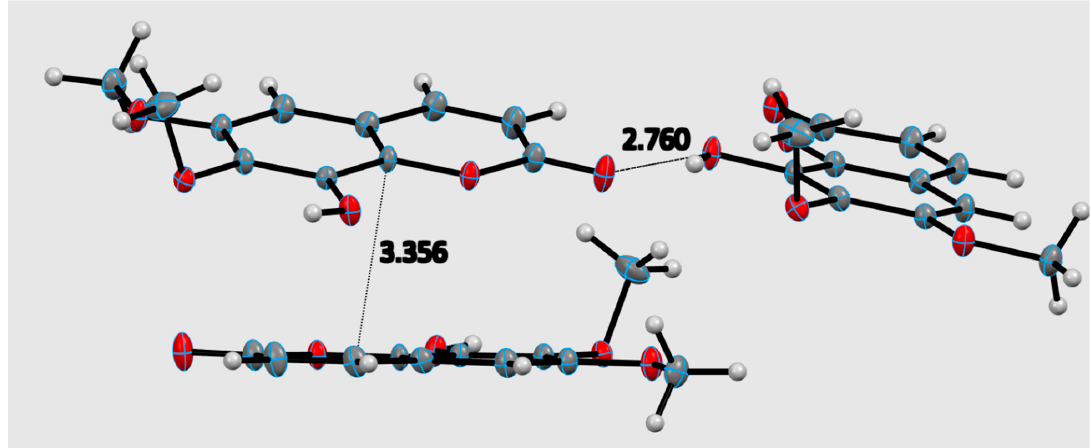
Figure 4. Stacking and hydrogen bonding interactions seen in the crystal structure of